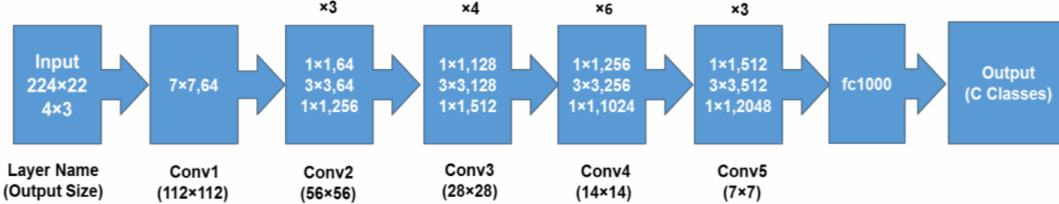
Figure 4. Block diagram of ResNet-50 architecture, where the number on the top of blocks shows the number of repeating units for each block and the number inside the block represents the layer output size and